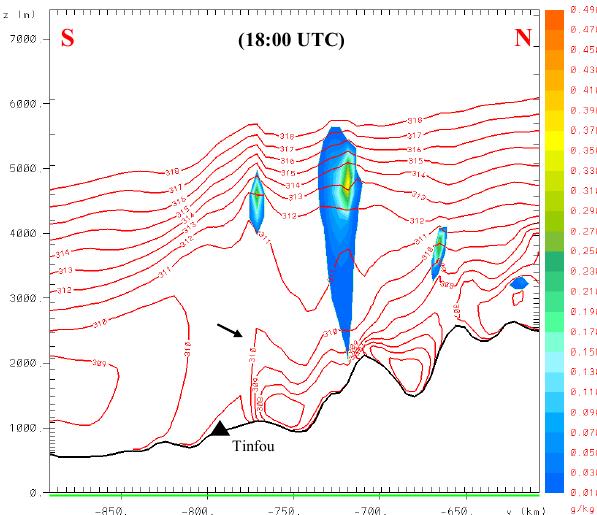
Fig. 11. North to south vertical cross-section of total condensates mixing ratio (colour scale in gkg − 1 ) and potential temperature (red contour lines in K) at 18:00UTC. The deepening of isentropic lay- ers (indicated with a black arrow) indicates the approaching of the density current at the station of Tinfou (denoted with a black trian- gle). The cross section is at x = −